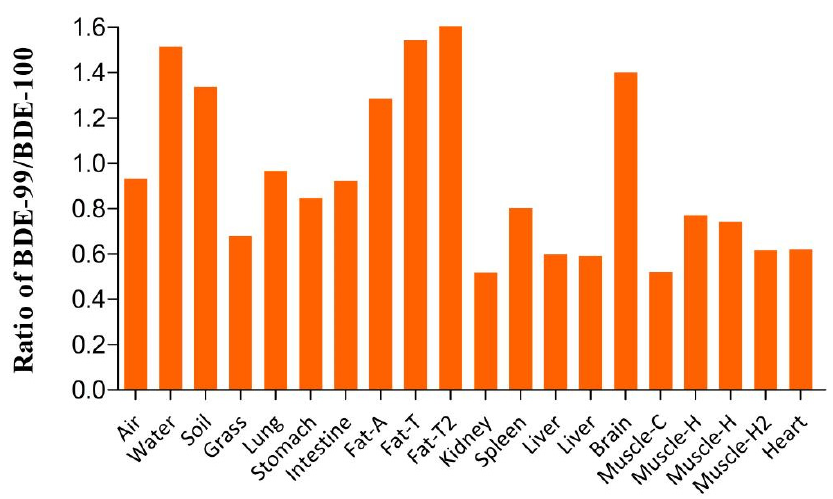
Figure 4. BDE-99/BDE-100 ratios in the environmental media and sheep tissue samples. 3.4. Abilities of PBDEs to Bind to Ovine Serum Albumin (OSA) and Cytochrome P450 Enzyme (CYP3A24)